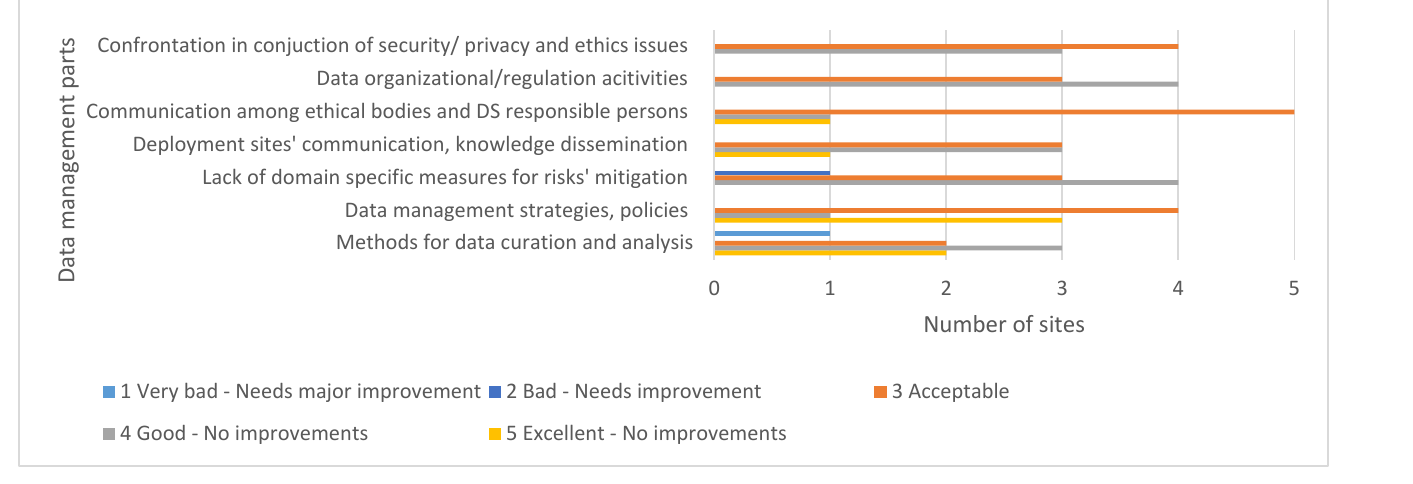
Figure 7. Evaluation of the ACTIVAGE LSP data management parts.